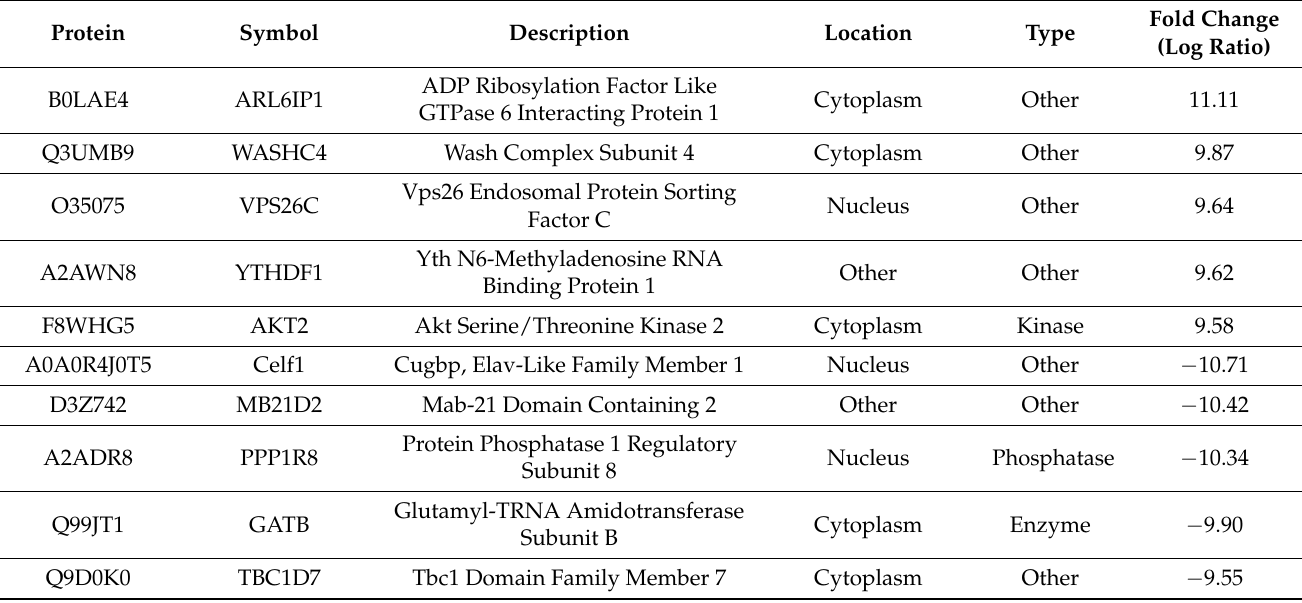
Table 2. Top upregulated and downregulated proteins associated with TAC-treated mice compared to TAC/PL-treated